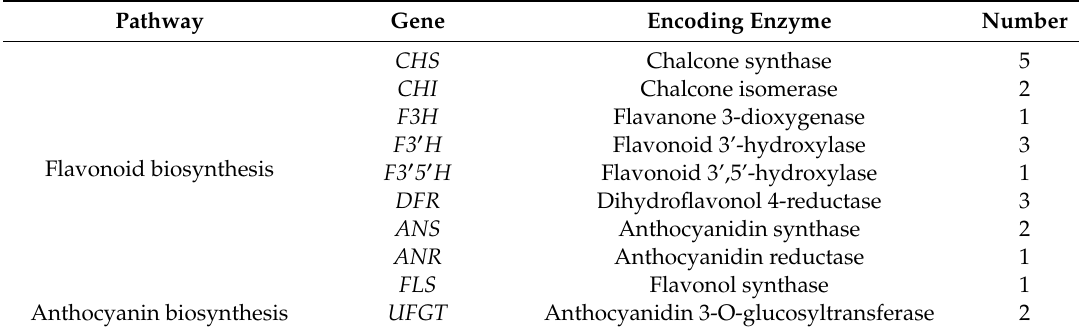
Table 4. Tentative anthocyanin biosynthesis pathway-related genes in P. limprichtii . Pathway Gene